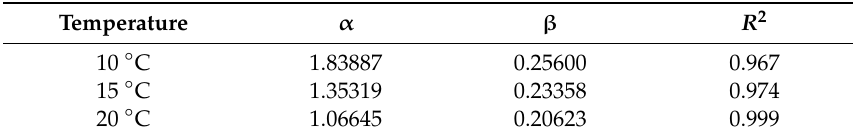
Figure 5. Law of changes related to indirect tensile strength with different loading rates and temperatures. Table 7. Fitting curve equation between indirect tensile strength and loading rate with di ff erent